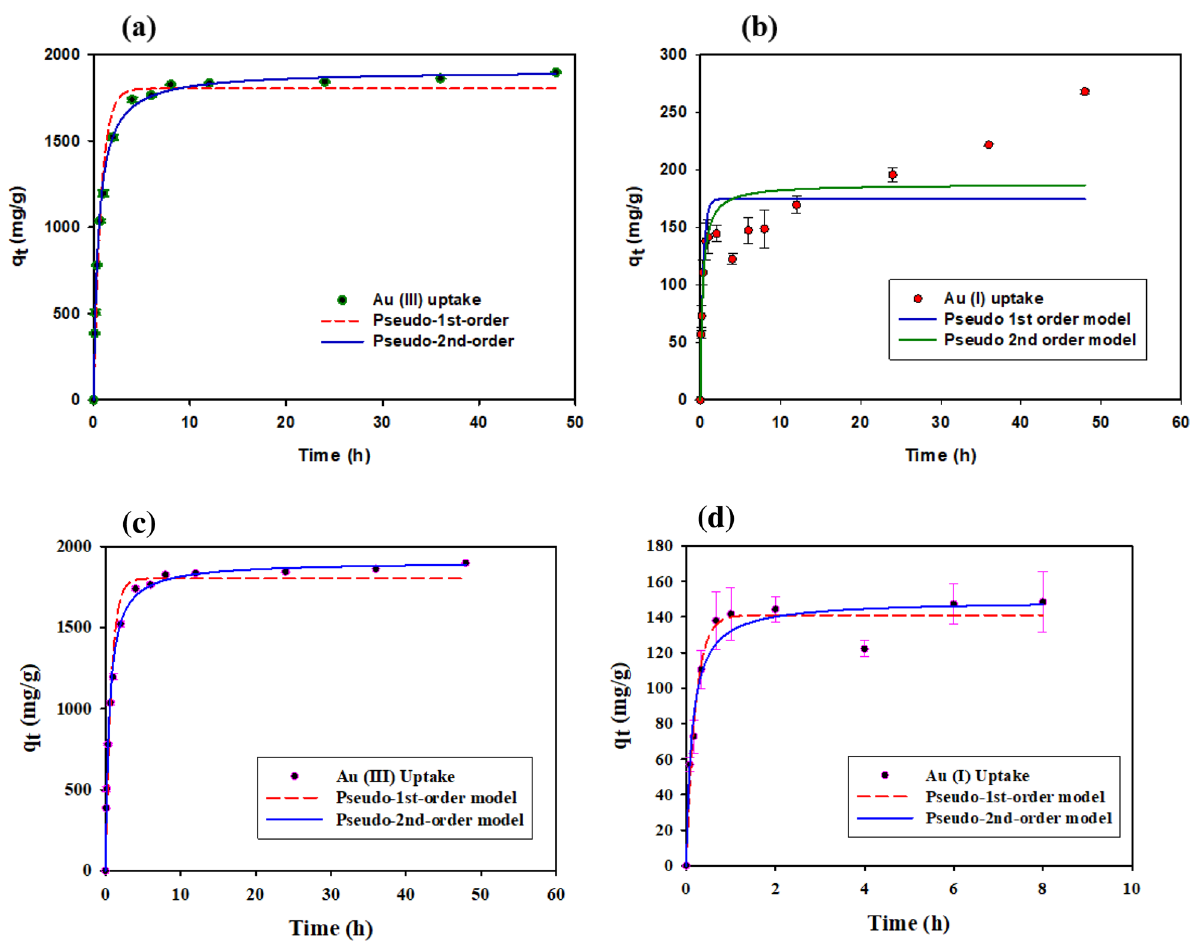
Figure 3. Kinetics of ( a ) Au (III) and ( b ) Au (I) adsorption into the capsule (C 0 = 1000 mg/L, pH = 2, t = 48 h, M ads /V sol = 0.4 g/30 mL, T = 25 ± 2